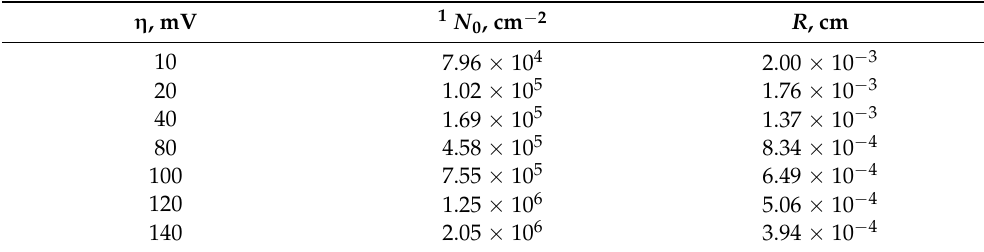
Table 1. Values of the overpotential, number density of nuclei, and the half-distance between the nearest neighbors (for hexagonal